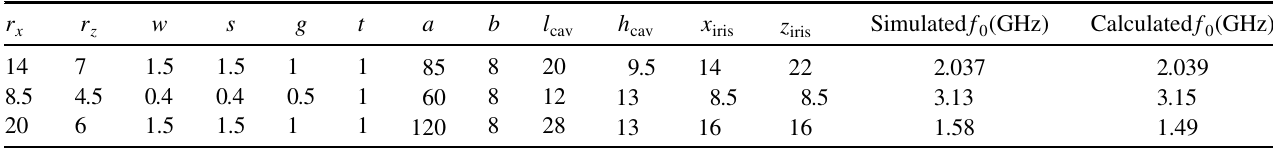
TABLE IV. Comparison between simulated and calculated deflecting structure operating frequencies.